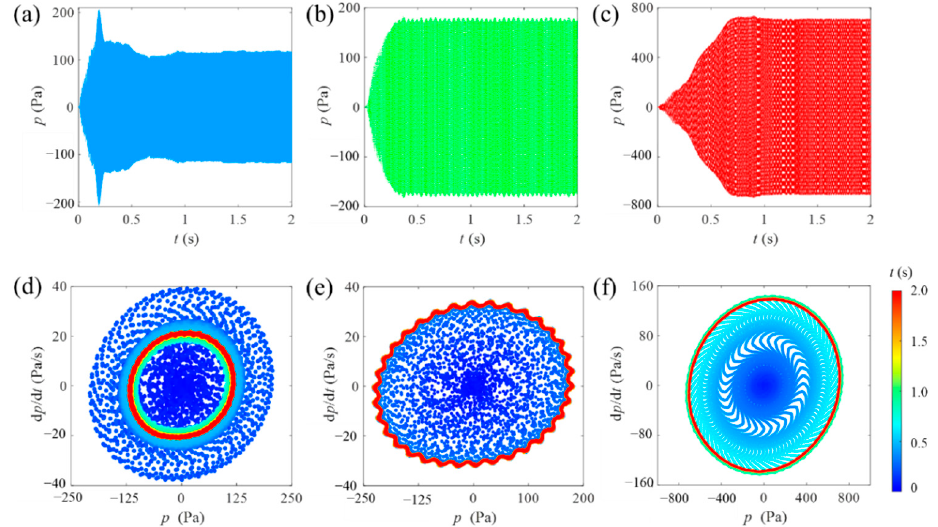
Figure 5. Acoustic pressure fluctuations. ( a – c ) Time evolution of pressure fluctuations, ( d – f ) corre- sponding phase diagram of pressure fluctuations at V a = 180 L/min T i = 300 K. ( a ) and ( d ) S N = 0.34, ( b ) and ( e ) S N = 0.45, ( c ) and ( f ) S N = 0.60.